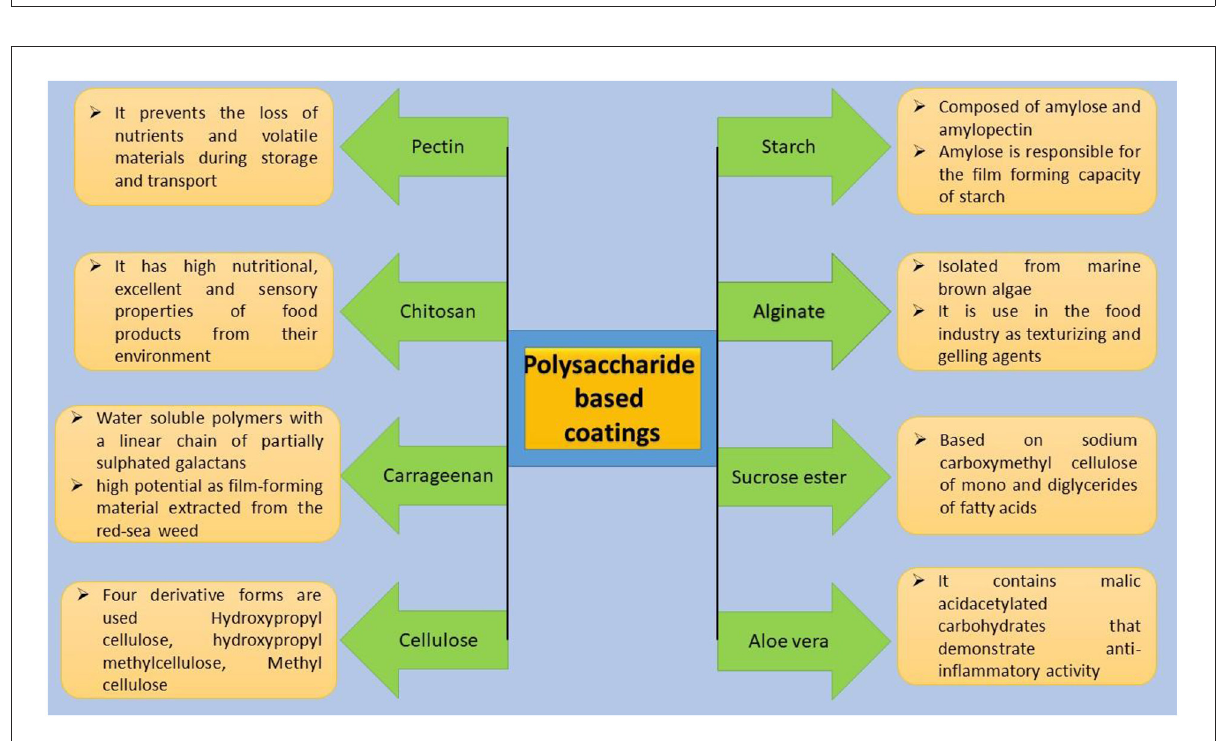
FIGURE14 Classification of polysaccharide based edible